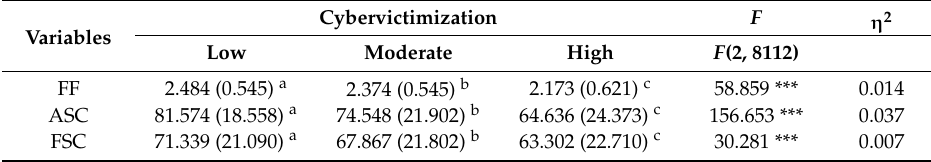
Table 2. Means, Standard Deviation (SD) and results ANOVA between cybervictimization and family functionning, family self-concept, and academic self-concept.